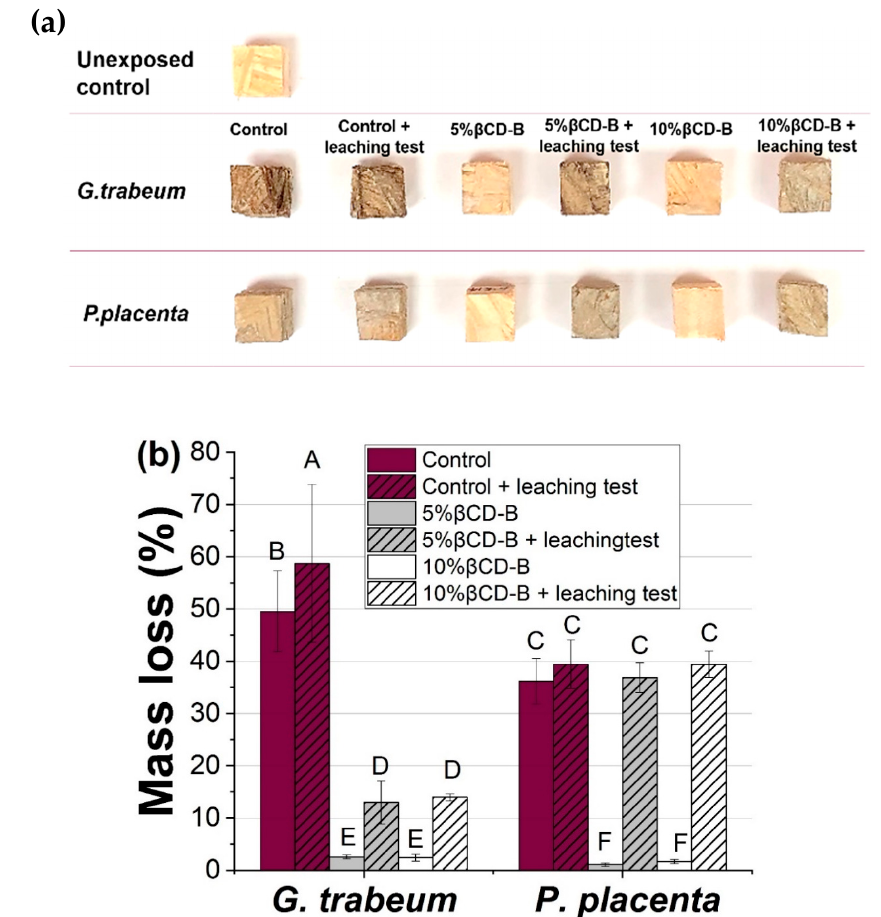
Figure 7. ( a ) Photograph and ( b ) mass loss of OSB treated with 0%, 5% and 10% β CD–B after eight week exposure to G. trabeum and P. placenta. Note: Means designated by the same letter are not significantly different (LSD, p < 0.05).